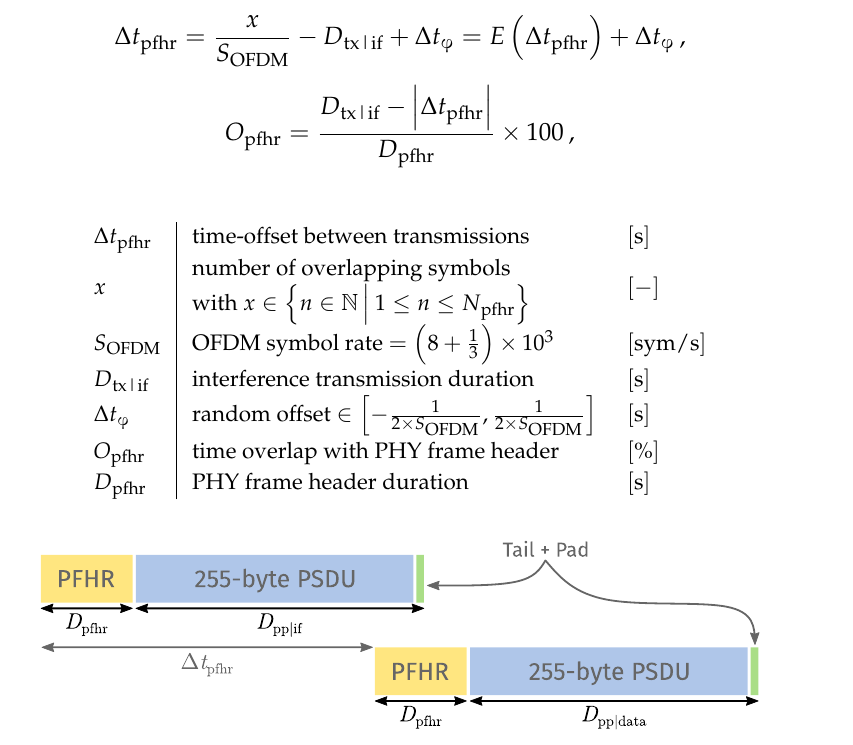
Figure 5. Time-domain overlap between a useful PPDU’s PFHR ( bottom ) and an interfering PPDU ( top ). The offset ∆ t pfhr follows from the interference transmit duration D tx|if and the number of overlapping symbols with the useful PFHR.